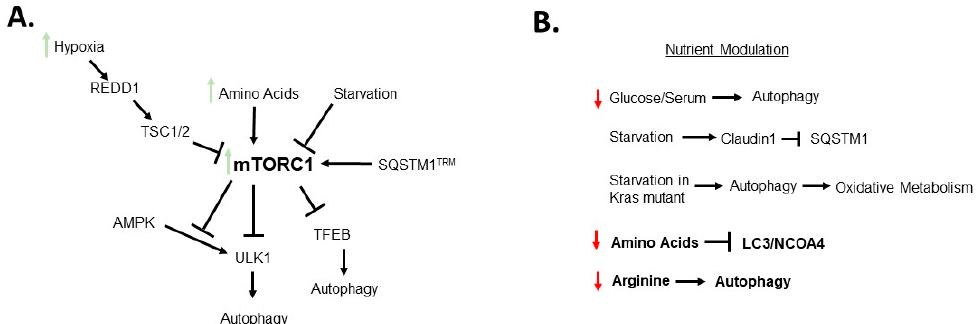
Figure 3. Schematic summarizing ( A ) Simplified overview of mechanisms of mTORC1 regulation. and ( B ) how nutrient modulation impacts autophagy. Bolded mechanisms indicate data from non-CRC samples. Please refer to text for detailed